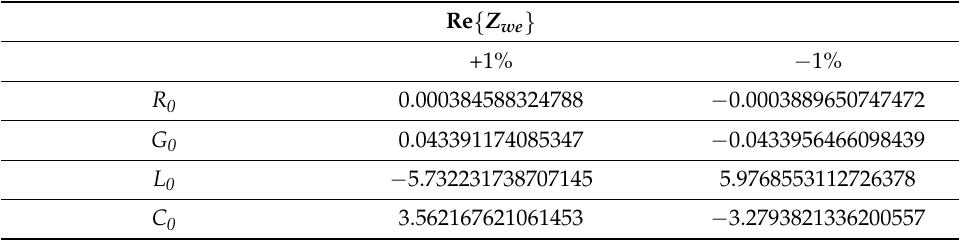
Table 4. Changes to the real part of the input resistance.